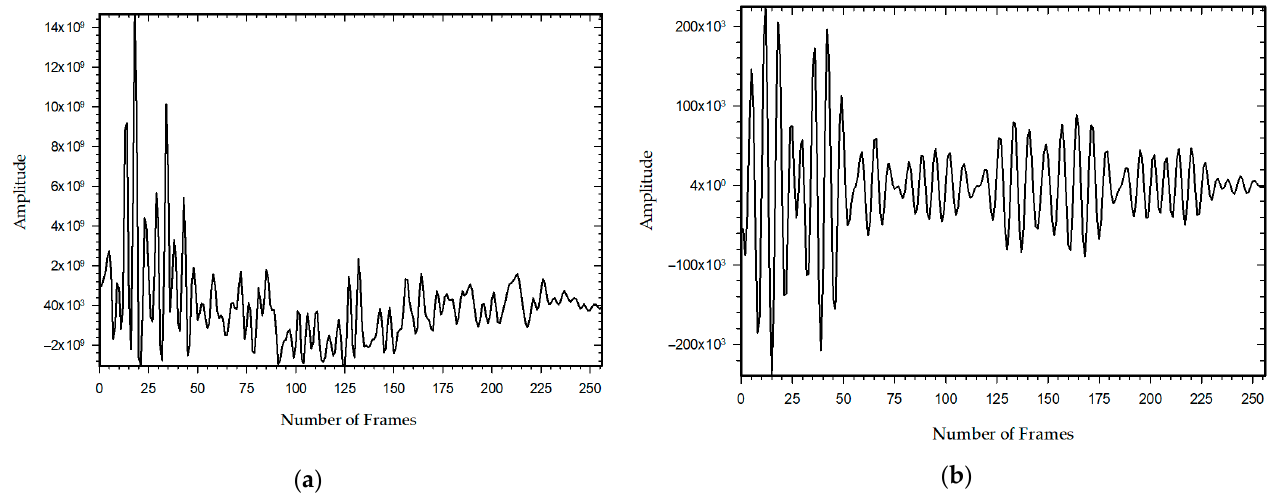
Figure 10. The received pulse shape and correlated signals from IR-UWB radar for PGSelect = 10; ( a ) received raw signal strength and; ( b ) correlated signal pulse.